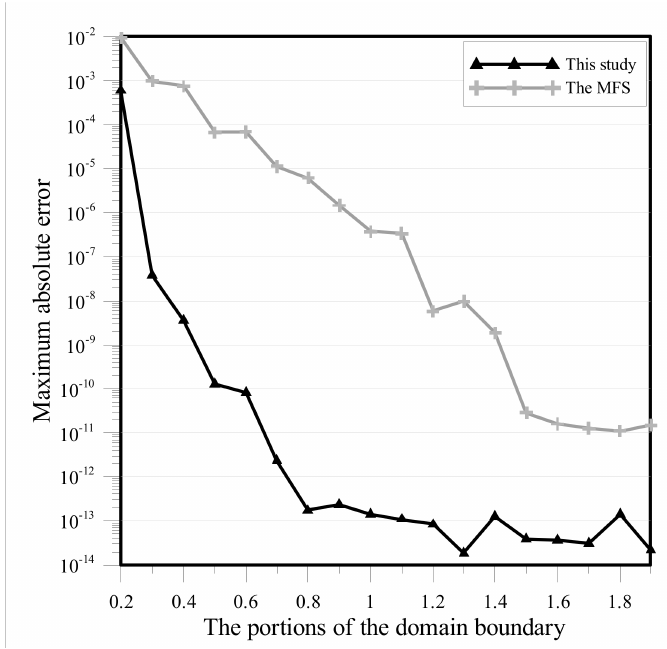
Figure 12. ζ versus the